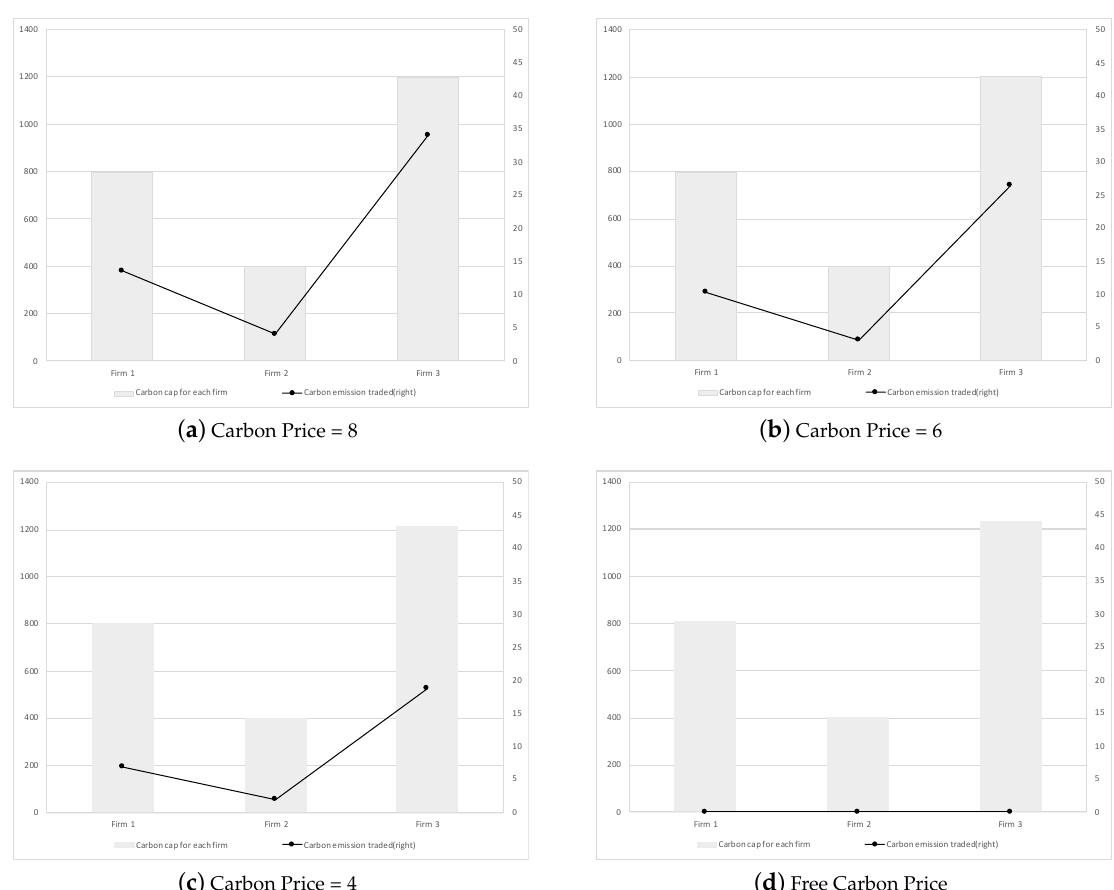
Figure 3. Carbon emission traded in cap and trade market at the different level of carbon price Each entity’s objective function for its production decision is made using the Newsvendor model. First, 352